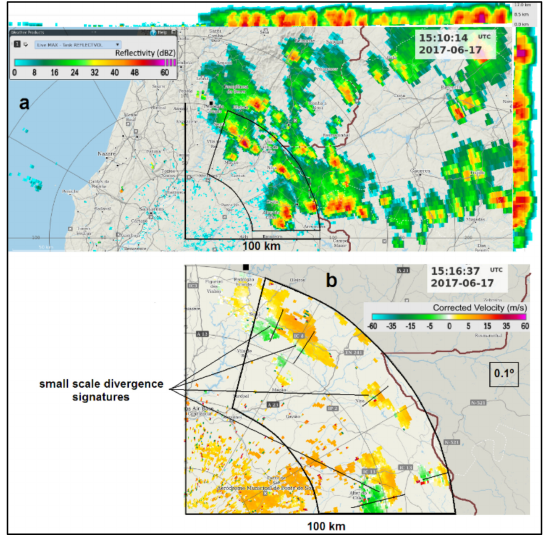
Figure 5. ( a ) MAXZ at 15:10 UTC, 17 June 2017, C/CL radar. Range rings are marked every 50 km. Segments mark the 100-km range. Fire areas are represented by a black square symbol. An azimuthal sector (50–100-km range) in the north–eastern quadrant observed by radar is also defined. Around the upper and right borders of the central image, the side panels of MAXZ are represented. ( b ) Zoomed-in area from ( a ) extracted from the Doppler scan, storm-relative velocity PPI, 0.1 ◦ tilt at 15:16 UTC, 17th June 2017, C/CL radar. Small radial segments depict small-scale divergence signatures coherent with discrete downburst activity. Border with Spain is represented by the brown